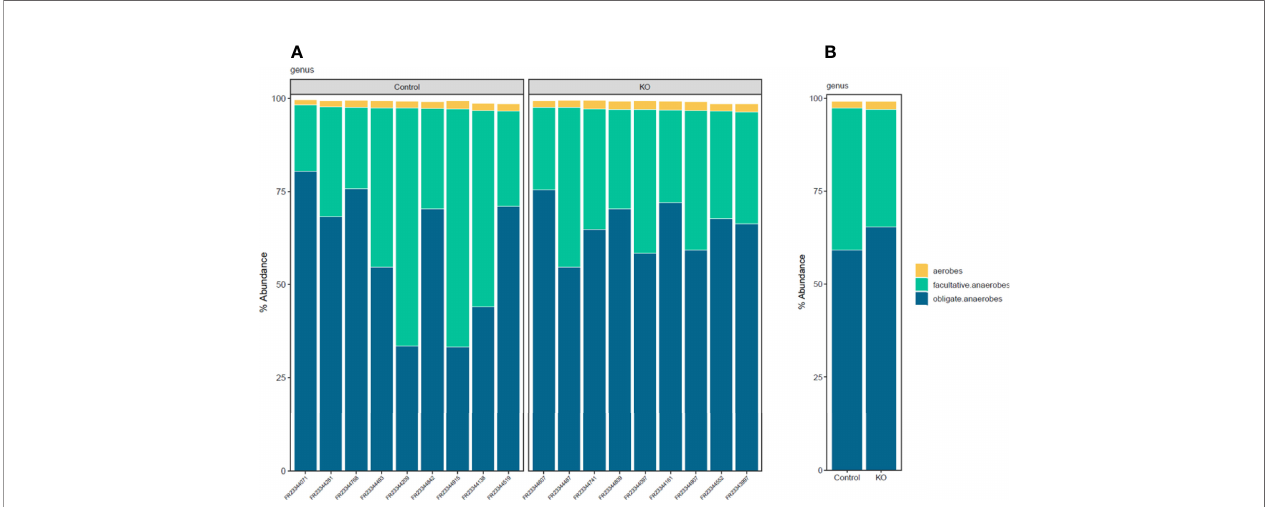
FIGURE 5 | Distribution histograms of aerobic and anaerobic microbial communities from NHE3 IEC-KO and control mice. Aerobic/anaerobic microbial communities pro fi ling (A) by samples, (B) by genotype groups, in NHE3 IEC-KO and control mice. N =